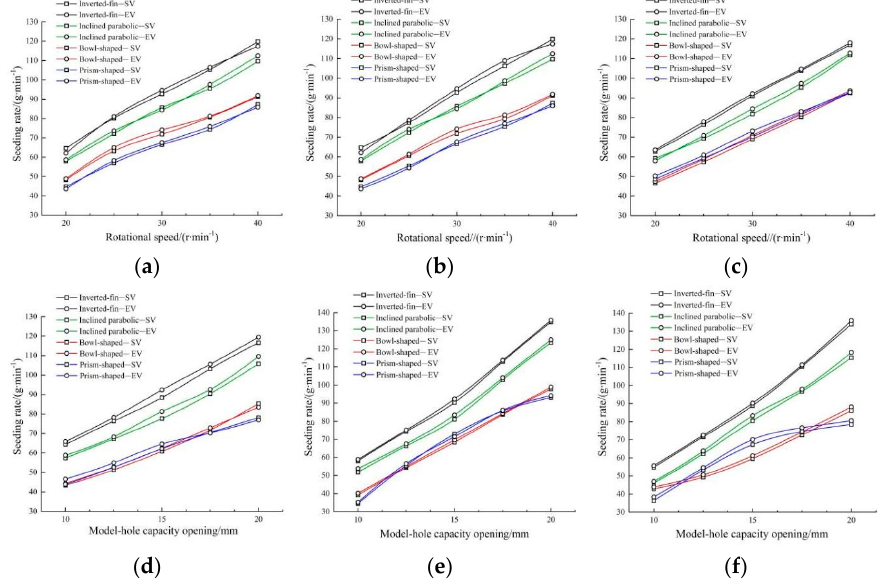
Figure 10. Comparison between simulation value and experimental value results. ( a ) Vibration fre-